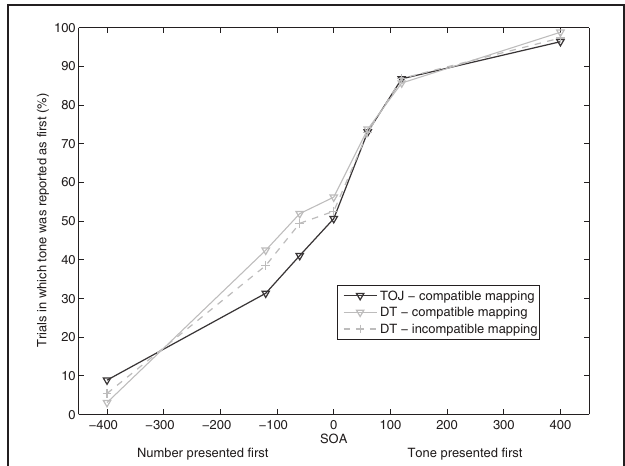
FIGURE 3 | Proportion of trials in which the auditory task was reported as first in the conditions of temporal-order judgment (TOJ) and dual task (DT) in Experiment 2. Two DT conditions were presented: DT with compatible stimulus-response mapping and DT with incompatible stimulus-response